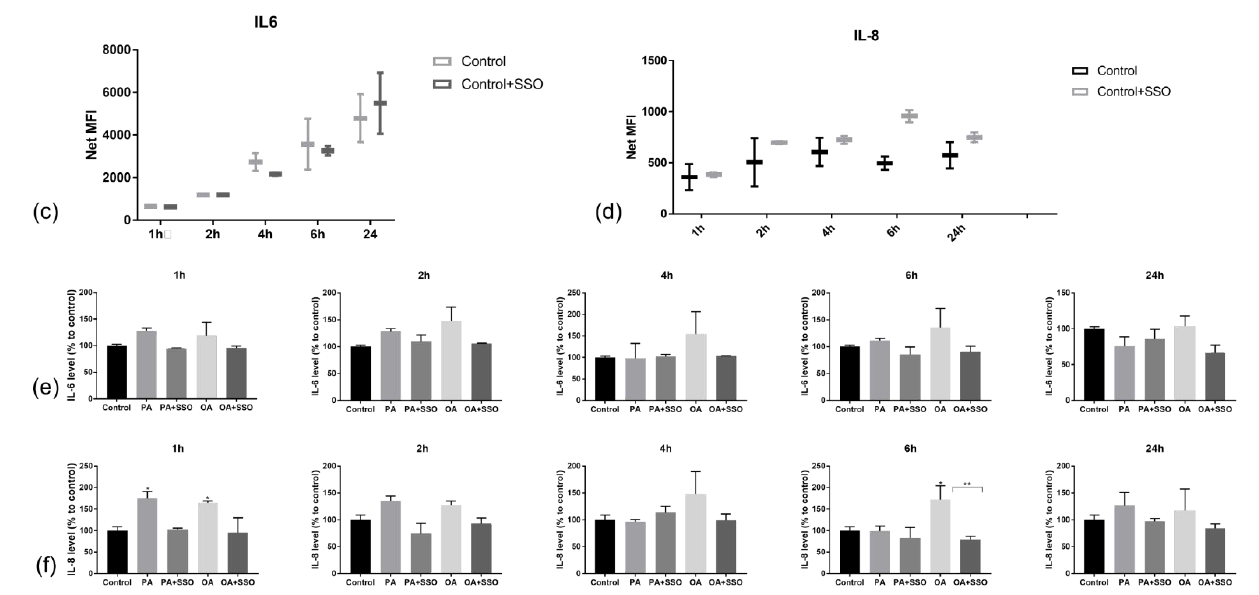
Figure 3. Assessment of cytokine release in NHA culture. NHAs were incubated with fibrillary 1–42 β -amyloid 0.2 µ M (as verified by cryo-EM ( a ) and IL-6 was measured by ELISA from cell culture medium at indicated times ( b ). The dynamics of IL-6 and IL-8 levels, w/o SSO pre-treatment (20 µ M, 10 min) were also measured in the cell culture medium using multiplexing ( c , d ). Levels of IL-6 ( e ) and IL-8 ( f ) in the presence of PA or OA in cells pre-treated with SSO were evaluated by xMAP array. Data are reported as a percentage to control. Statistical analysis was performed by one-way ANOVA, Dunnett multiple comparison, where data were compared to control (* p < 0.05, ** p < 0.01).